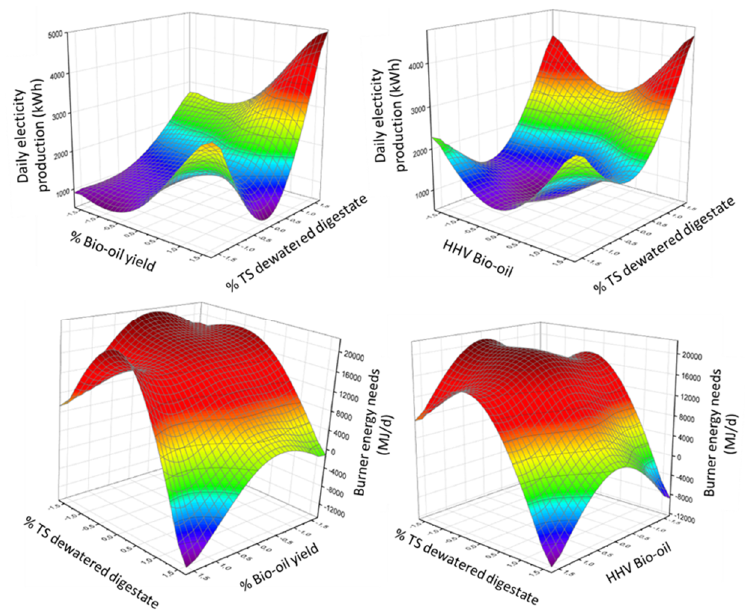
Figure 2. Representation of the behavior of responses: Y1: Daily electricity production, Y2: Supplied of energy to the burner. Factors X1: bio-oil yield, and X3: %TS in dehydrated digestate.